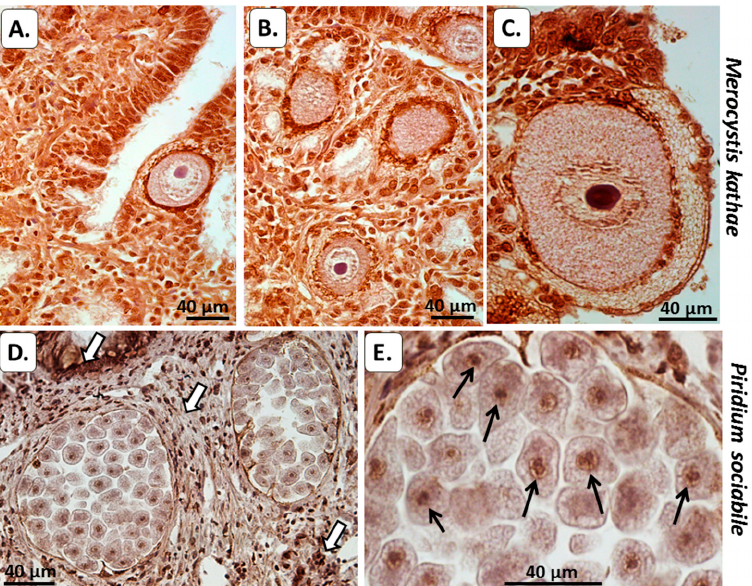
Figure 5. Deiminated/citrullinated histone H3 (CitH3) in the two alveolates under study. ( A – C ) Whelk kidney infected with M. kathae . Strong host-reaction indicative of NET/ETosis is observed by the increased CitH3 staining in tissue surrounding M. kathae infection. In M. kathae , strong CitH3 positive is observed in the outer membrane, cytoplasm, nucleus and nucleolus. ( D ) Two P. sociabile cysts in a whelk foot. Quite strong reaction is evident in the surrounding host tissues, both in the whelk fibromuscular connective tissue as well as the epithelial layer (white arrows). ( E ) Higher magnification of several parasite bodies showing moderate CitH3 reaction in the cytoplasm and strong reaction in the nuclear membrane and the nucleolus (black arrows). Scale bar is indicated in each figure and is 40 µm.